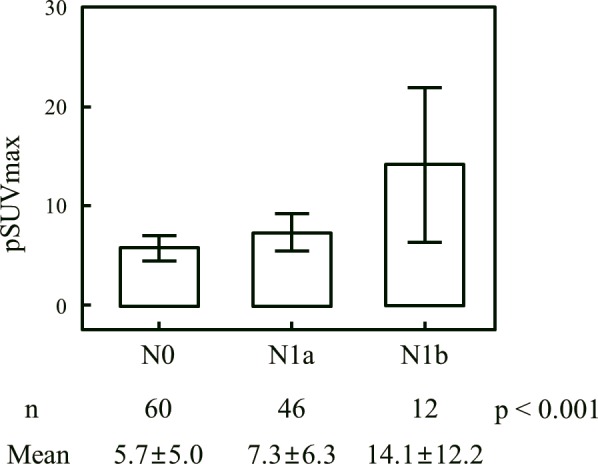
Relationship between pSUVmax and N stage*.Fig 2 shows that the pSUVmax was associated with N stage (p < 0.001) in the FDG avidity group (n = 118).* Based on TNM (tumor, node, metastasis) staging system defined by the American Joint Committee on Cancer.